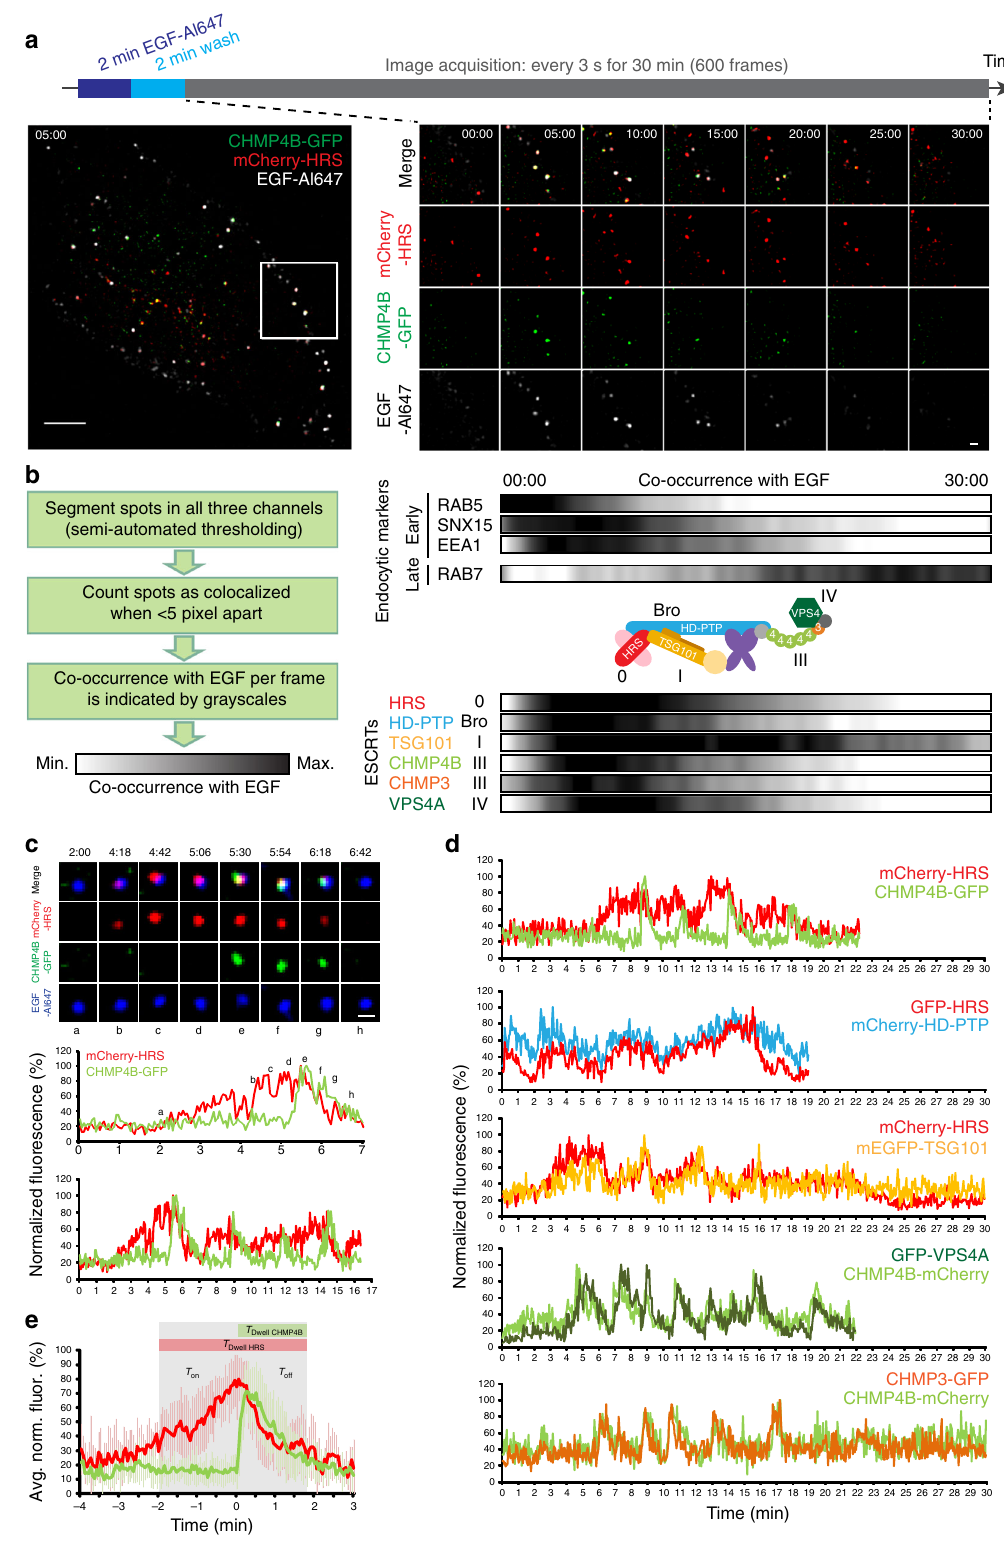
ESCRT-dependent ILV formation is independent of endosome maturation . From our co-occurrence analysis we observed the main ESCRT activity from early on until approximately 15 – 20 min of live-cell imaging, while the RAB7 endosome maturation switch seemed to occur from approximately 15 min